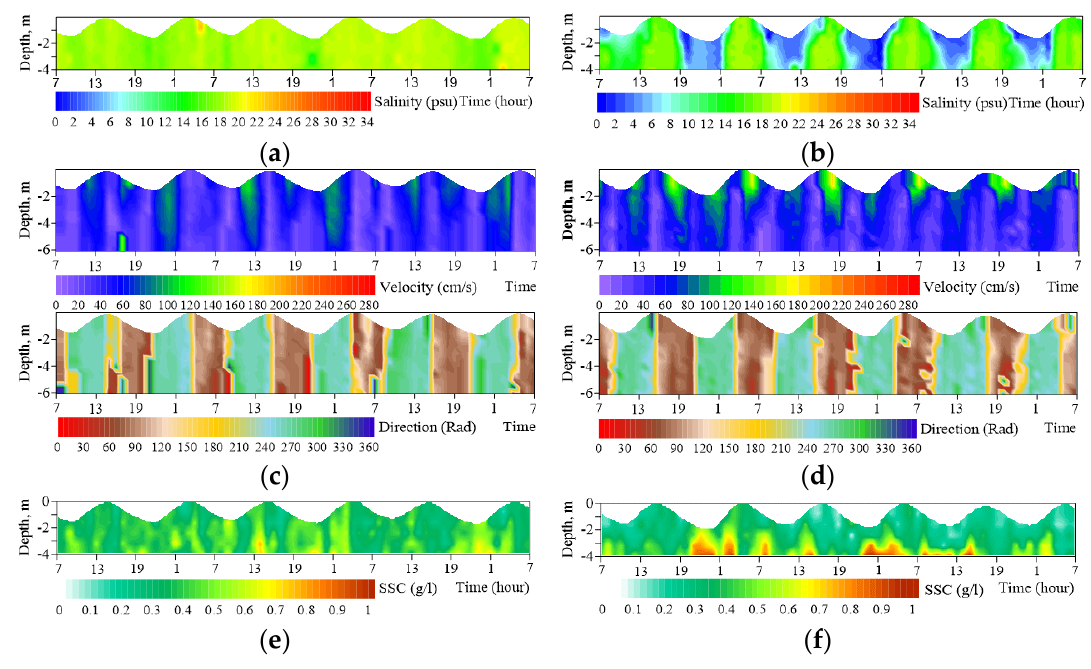
Figure 7. Time series plot of the distribution of salinity, currents (velocity, direction), and SSC at Station S12 in the dry season (9–12 April 2009) and the flood season (22–25 August 2009): ( a ) salinity in the dry season; ( b ) salinity in the flood season; ( c ) current in the dry season; ( d ) current in the flood season; ( e ) SSC in the dry season; ( f ) SSC in the flood season.